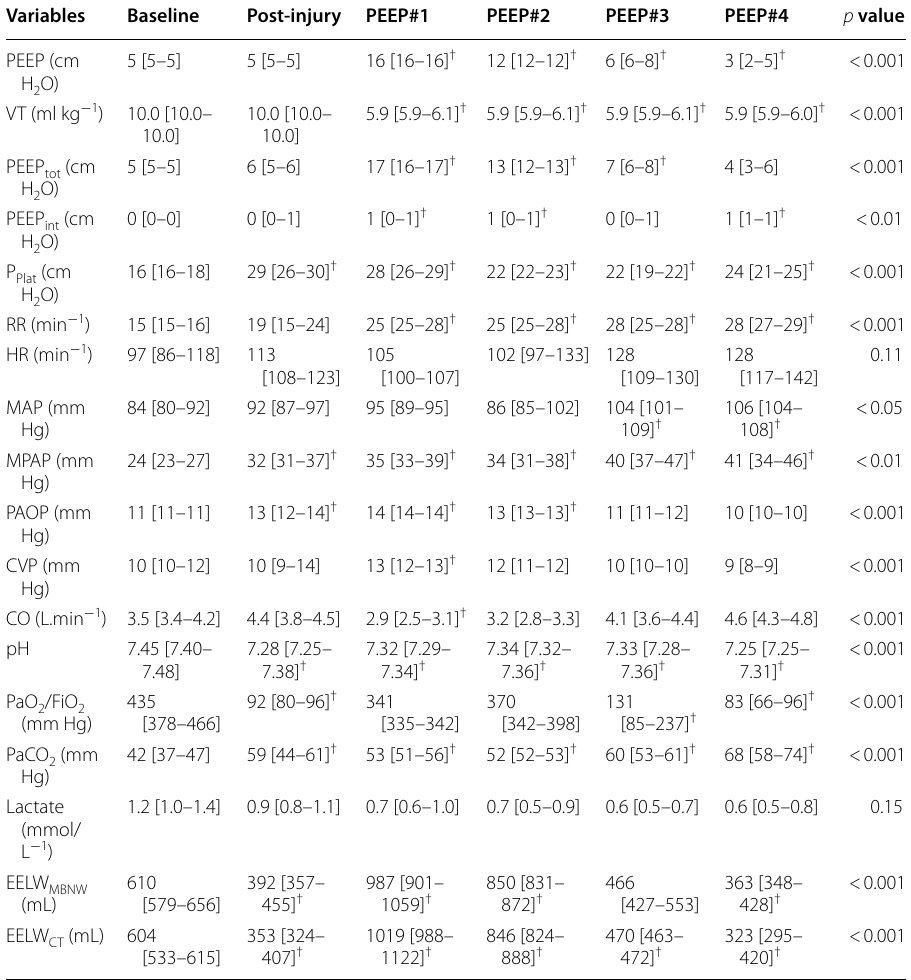
Table 1 Variables repeatedly assessed over